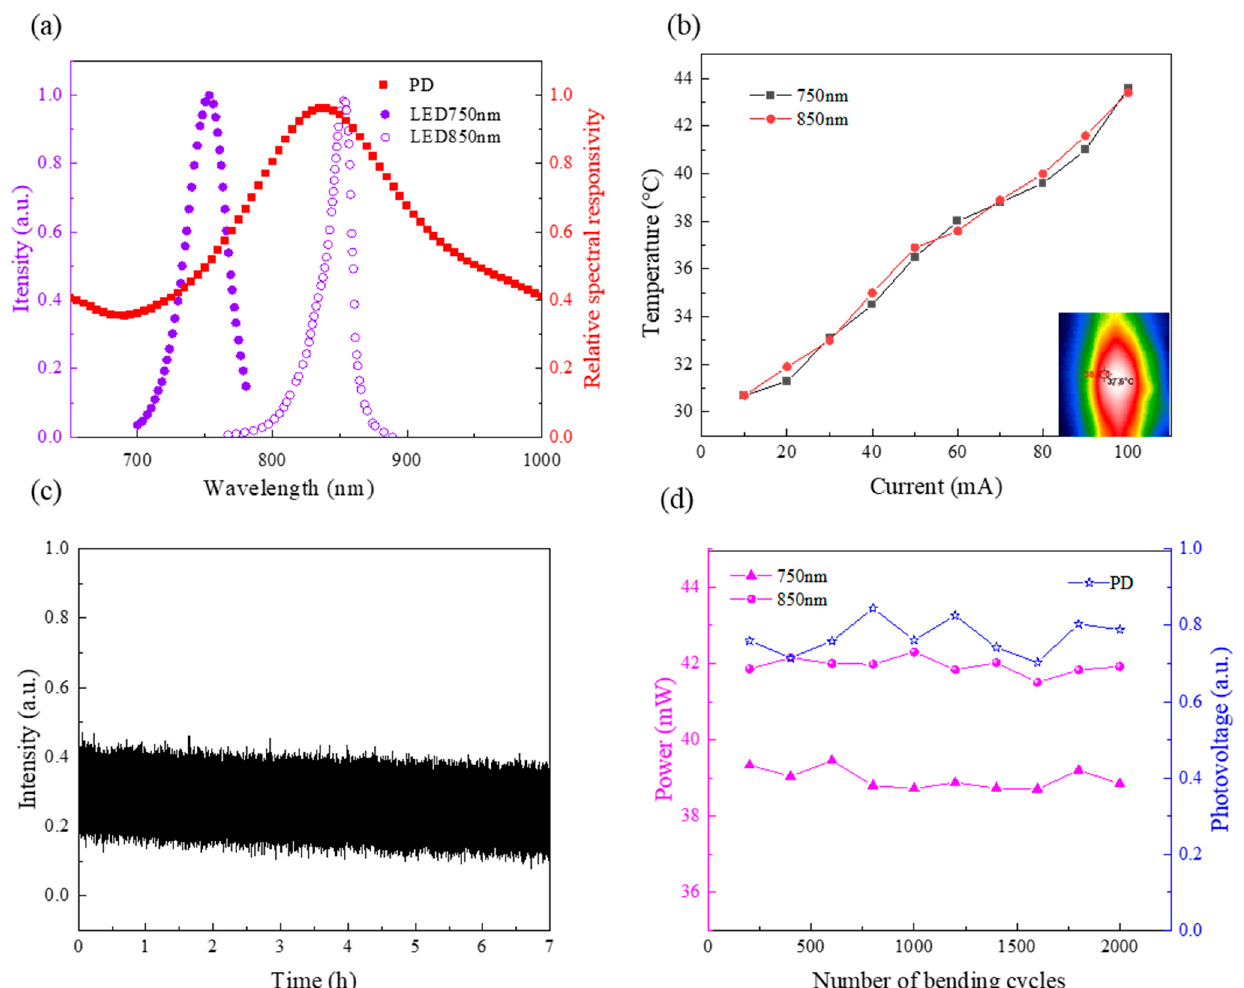
Figure 2. Optical, thermal and electronic characteristics. ( a ) Light emission spectrum characteristics for sensor probe LEDs and PDs. ( b ) Measurement of LED temperature as a function of current. ( c ) The flexible fNIRS device continuously monitors the voltage value of PD for 7 h. ( d ) LED luminescent power and PD response voltage after 2000 bending cycles.